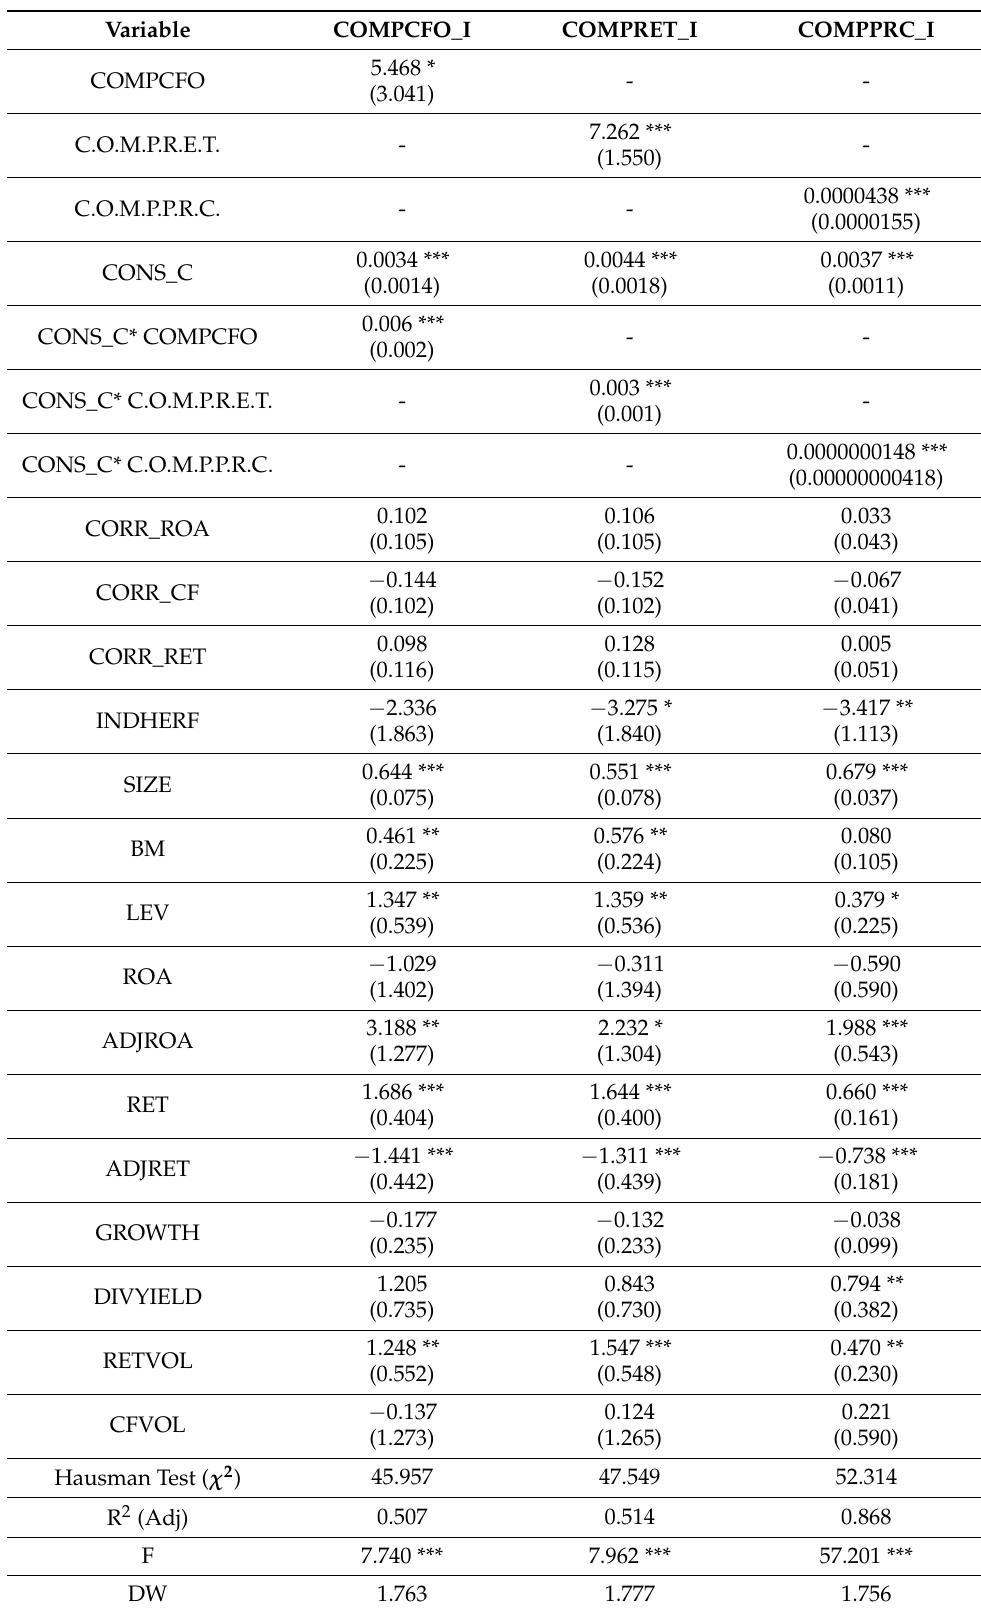
Table 4. Compensation and accounting comparability: conditional